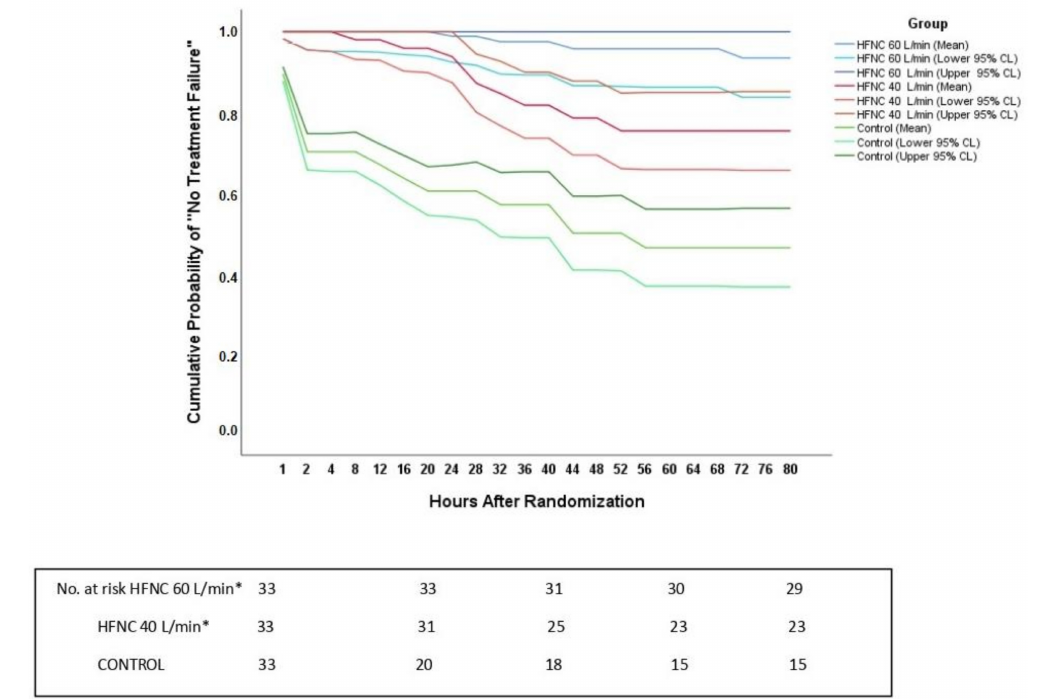
Figure 2. Cumulative probability (mean, 95% confidence interval) of the absence of treatment failure (i.e., “no treatment failure”) in intervention group 1 (HFNC 60 L/min), intervention group 2 (HFNC 40 L/min), and control group. HFNC, high-flow nasal canula. Cox model covariates: group, European System for Cardiac Operative Risk Evaluation (EuroSCORE) II (which includes age and gender as risk factors), body mass index, cardiopulmonary bypass time, duration of postoperative sedation, and duration of pre-extubation assisted and spontaneous breathing values. Collinearity diagnostics: condition index: 22.0; variance inflation index: 1.07–1.36. CL, confidence limit. * Initial HFNC gas flow level.